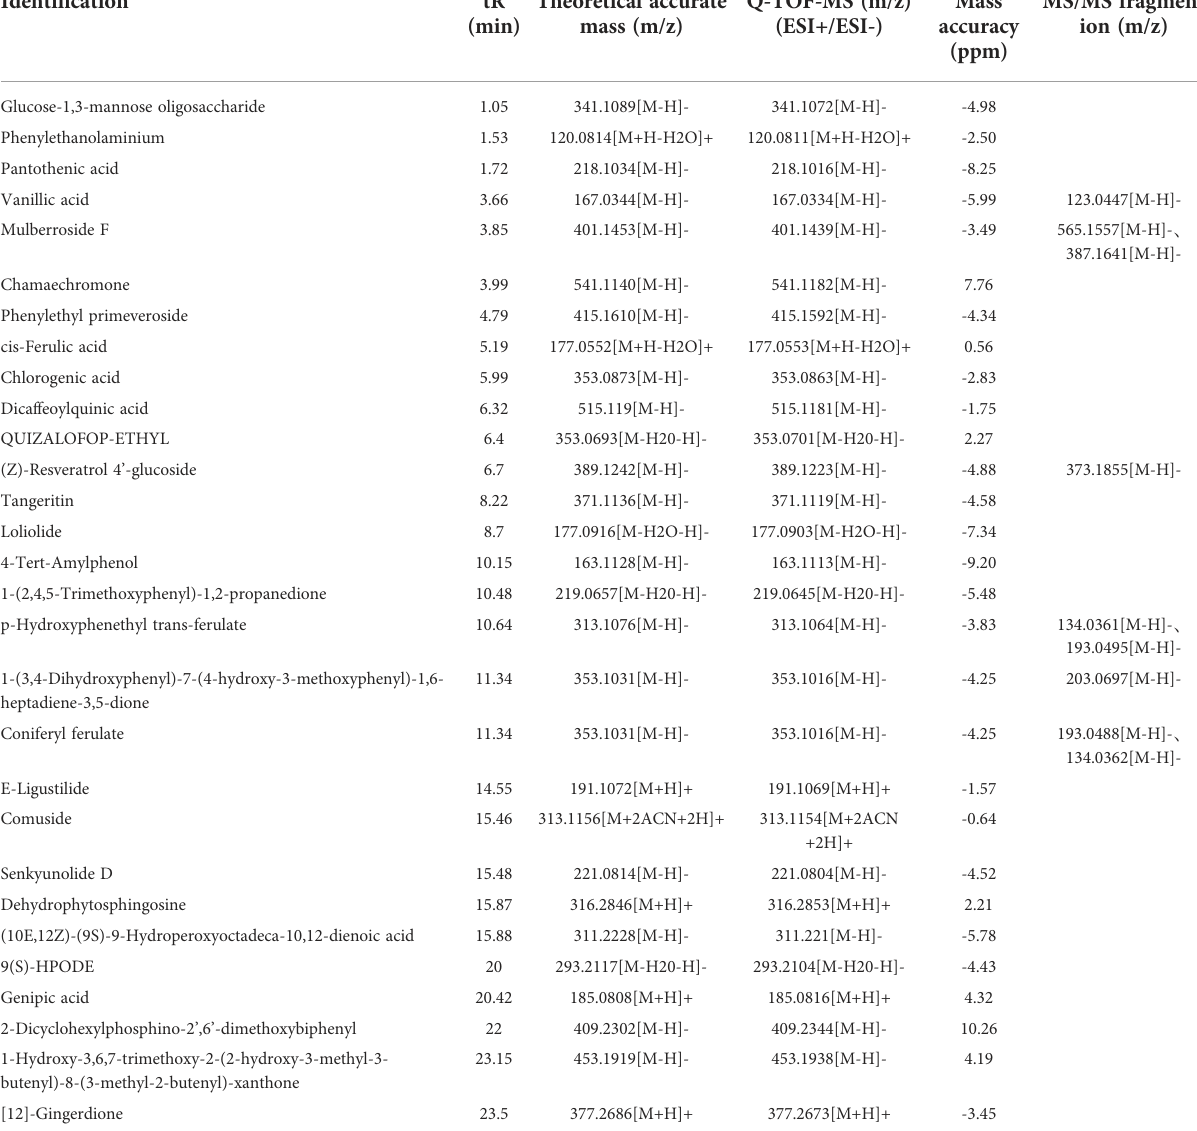
TABLE 2 Differential metabolites for discriminating A. sinensis samples between M and G. Identi fi